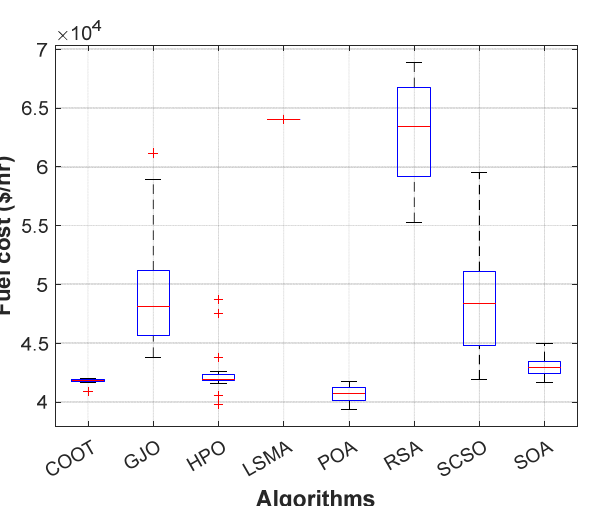
Figure 20. The voltage profile of the POA and other compared algorithms for case 1 in a standard IEEE 57-bus test system.